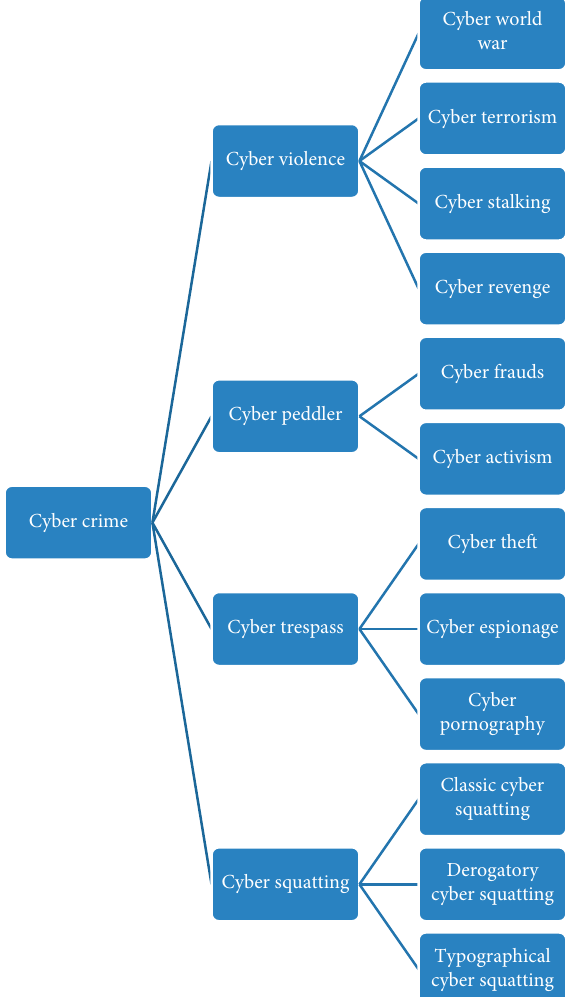
Figure 2: Taxonomy of the